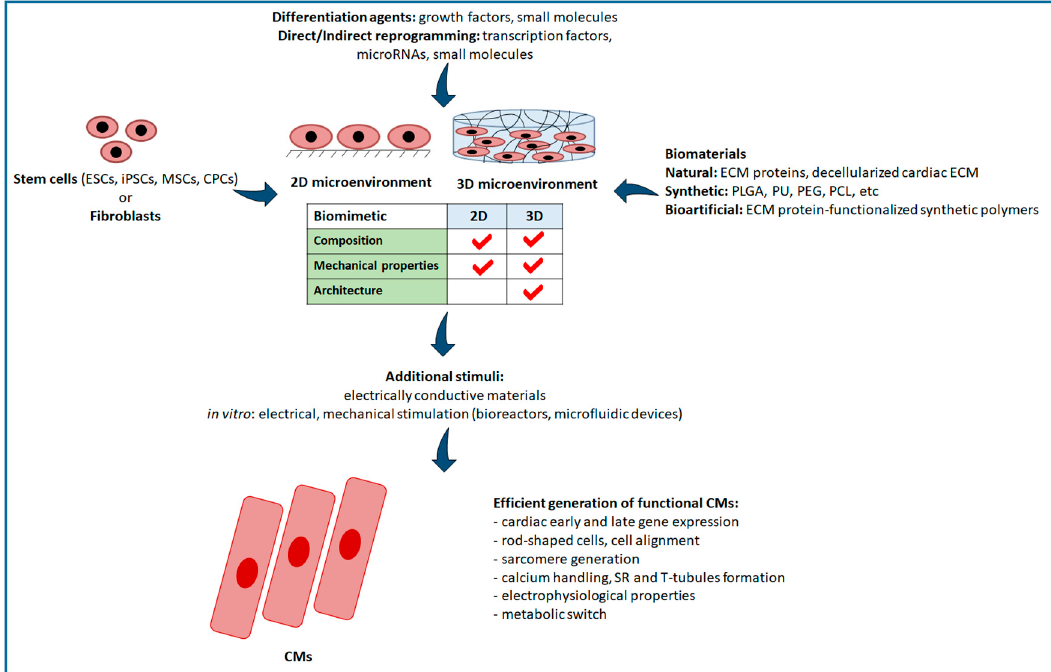
Figure 2. Schematic representation of CM generation. Functional and mature CMs can be obtained starting from different cell sources: through cardiac differentiation of stem cells (ESCs, iPSCs, MSCs and CPCs) or fibroblast direct and indirect reprogramming into CMs. These processes are mainly guided by differentiation agents (growth factors and small molecules) or reprogramming agents (TFs, microRNAs and small molecules). Cell differentiation and reprogramming can be performed in the presence of biomaterials, which are classified as natural (ECM proteins and decellularized cardiac ECM), synthetic (PLGA, PU, PEG, PCL, etc.) and “bioartificial” (ECM protein-functionalized synthetic polymers) using a 2D or 3D microenvironment. 3D cell culture offers a structure that mimics natural microenvironment. Additional stimuli for CM generation can be provided by electrically conductive materials or electrical and mechanical stimulation in bioreactors and microfluidic devices. Peculiar features of functional CMs assess the level of CM maturation. Table 1. Influence of different biomaterial substrates on stem cell differentiation and fibroblast (direct and indirect) reprogramming into cardiomyocytes.